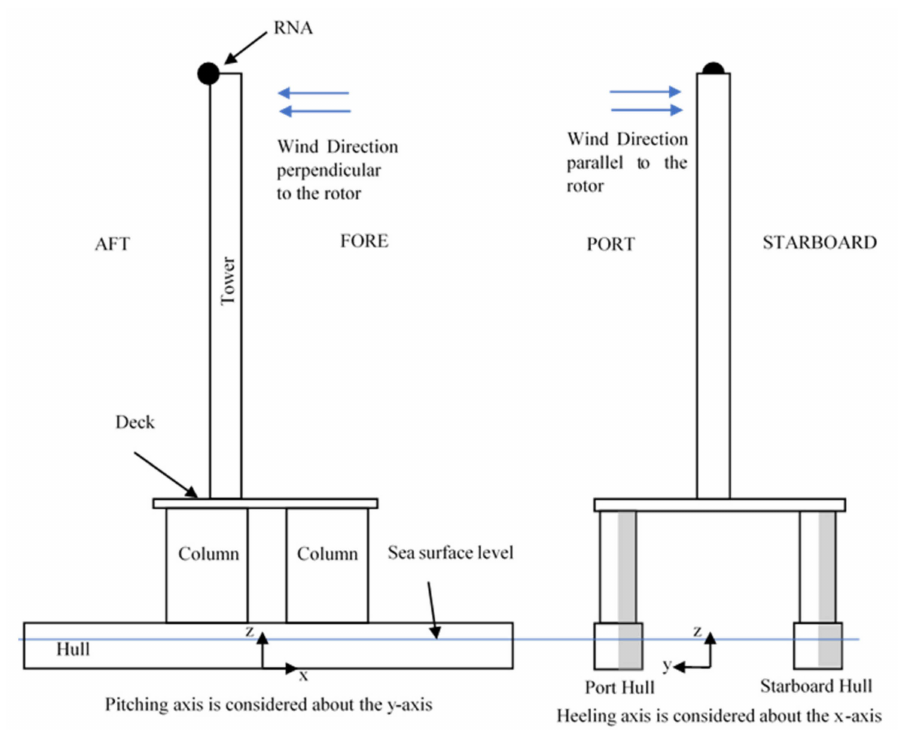
Figure 5. SA: RW wind direction.